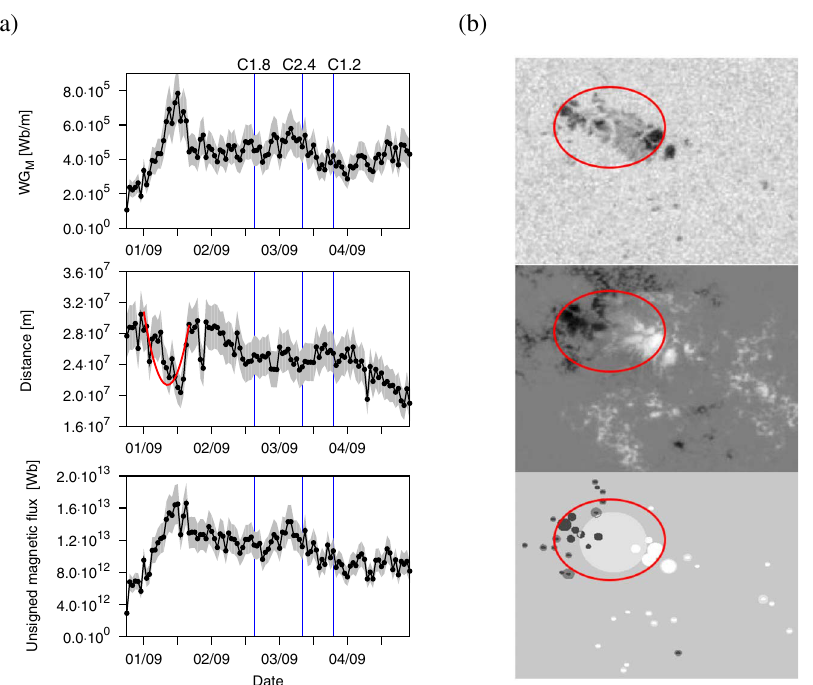
Fig. 2. (a) Representative example for applying the WG M method to GOES C-class fl ares in AR 11281. (b) Top/middle and bottom panels are the associated intensity/magnetogram maps and the Debrecen catalogue representation of the associated synthetic polarity drawing at 00:59 on 03 September